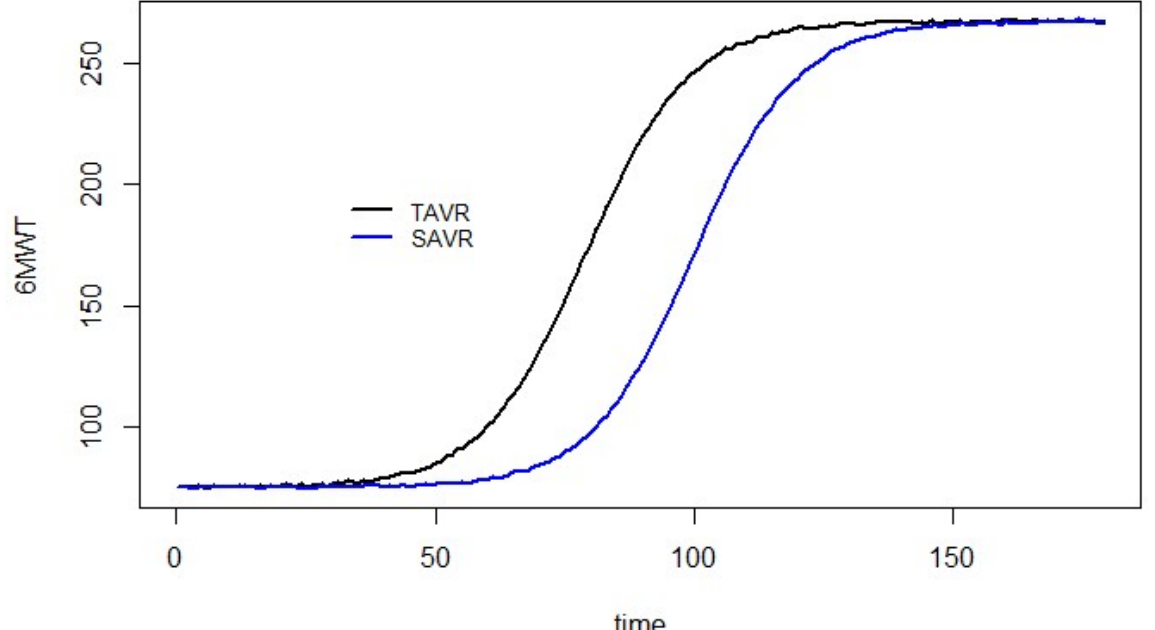
Figure 2. Simulated growth rate for the 6-Minute Walk Test (6MWT). SAVR: surgical aortic valve replacement; TAVR: transcatheter aortic valve